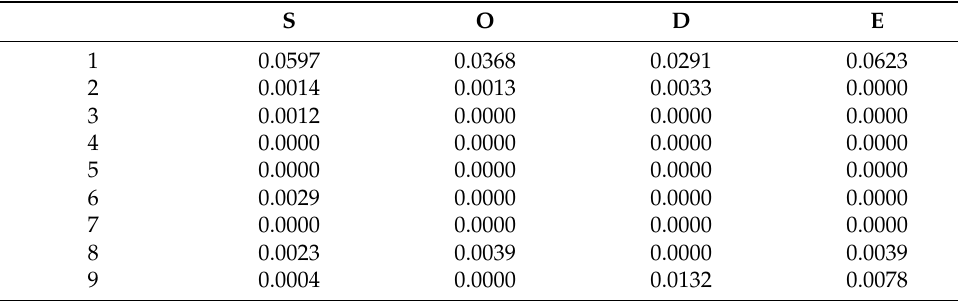
Table 6. The distance between γ ij and NIT j ( δ ij ).